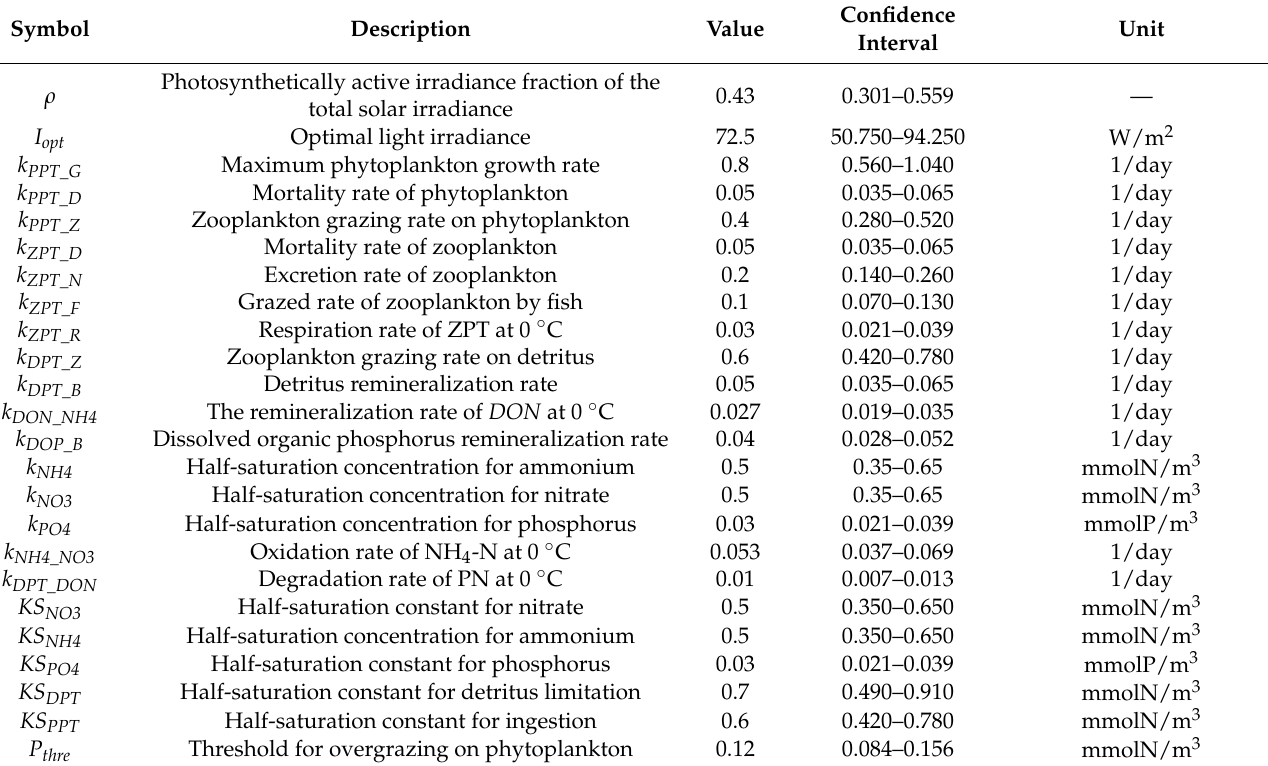
Table 1. Values and units of the parameters of the water quality model.